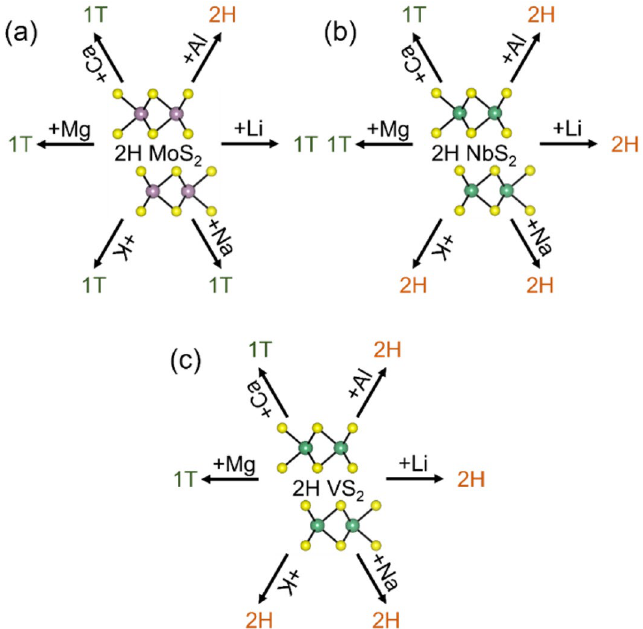
Figure 1. Schematic showing the resultant phases upon intercalation of various ions in 2H-( a ) MoS 2 , ( b ) NbS 2 and ( c ) VS 2